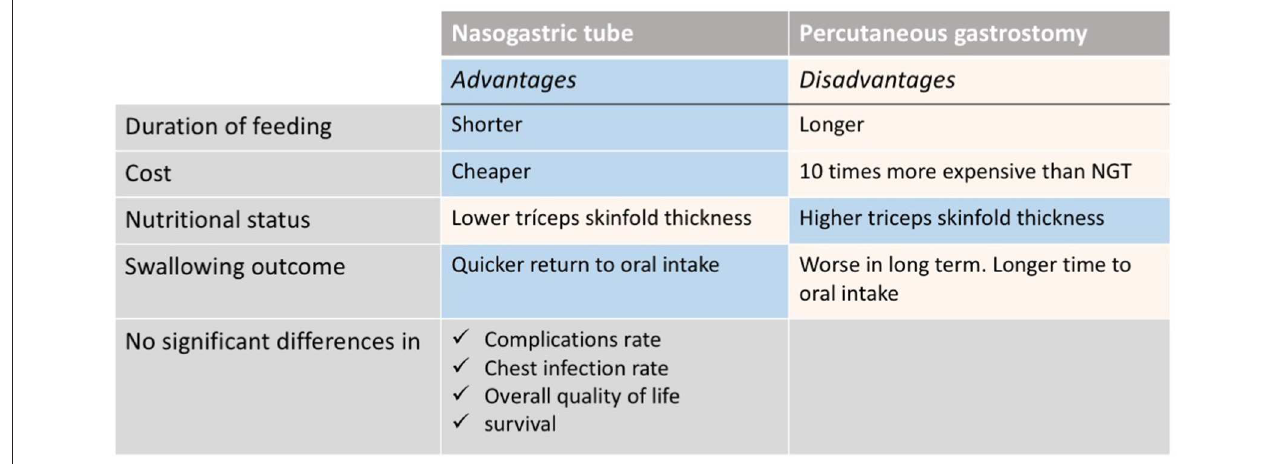
FIGURE 2 | Nasogastric tube vs. percutaneous endoscopic gastrostomy: advantages and disadvantages [Extracted from Wang et al.